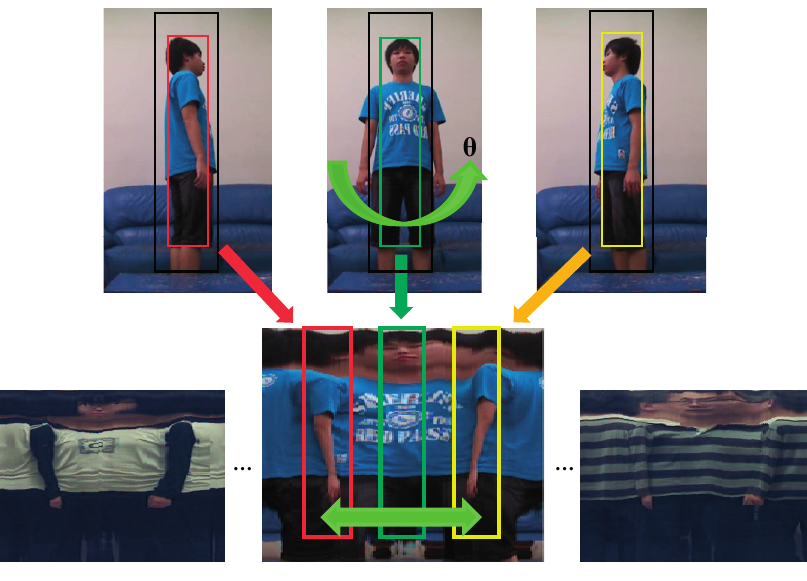
Figure 3. FCT-based human identification and